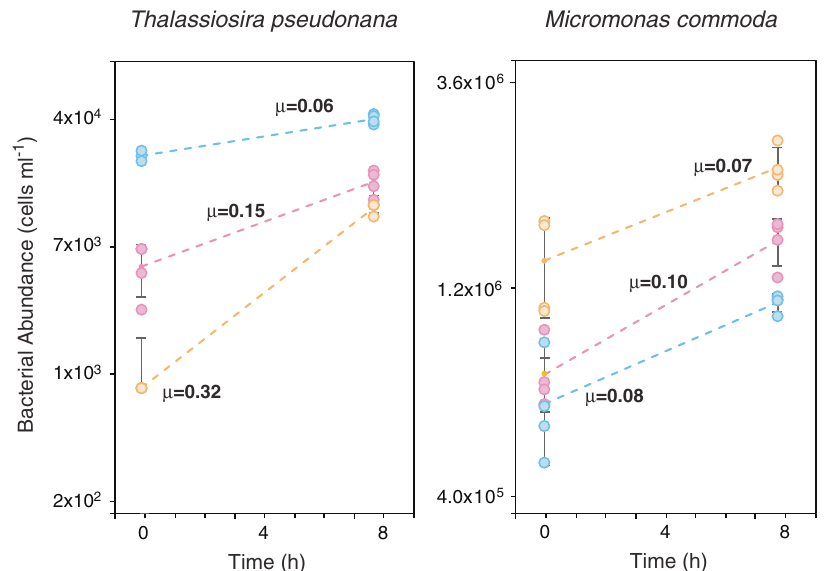
Fig. 3 Bacterial growth during 8 h incubations with microphytoplankter Thalassiosira pseudonana and picoeukaryotic phytoplankter Micromonas commoda . Replicates ( n = 4) are plotted individually, and standard errors of the means are indicated. Speci fi c growth rates ( μ , in units of h − 1 ) are estimated from the T0 and T8 cell numbers, assuming exponential growth. Pink symbols, Ruegeria pomeroyi DSS-3; blue symbols, Stenotrophomonas sp. SKA14; orange symbols, Polaribacter dokdonensis MED152. Initial phytoplankton exometabolite pools consisted of organic compounds released during 7 d of axenic culture (exponential through early stationary